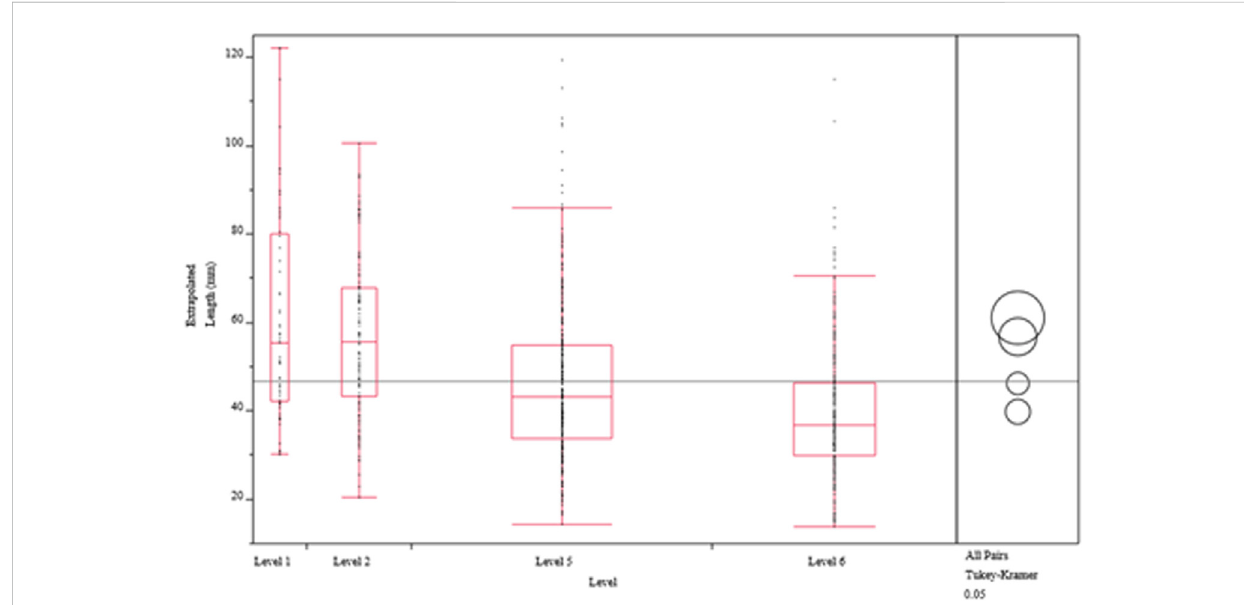
FIGURE 7 Mussel umbone data from CA-SCR-14. Data from Excavation Unit 2 and separated by excavation level. AMS Range 1160 CE- 1920 CE. N = 696.